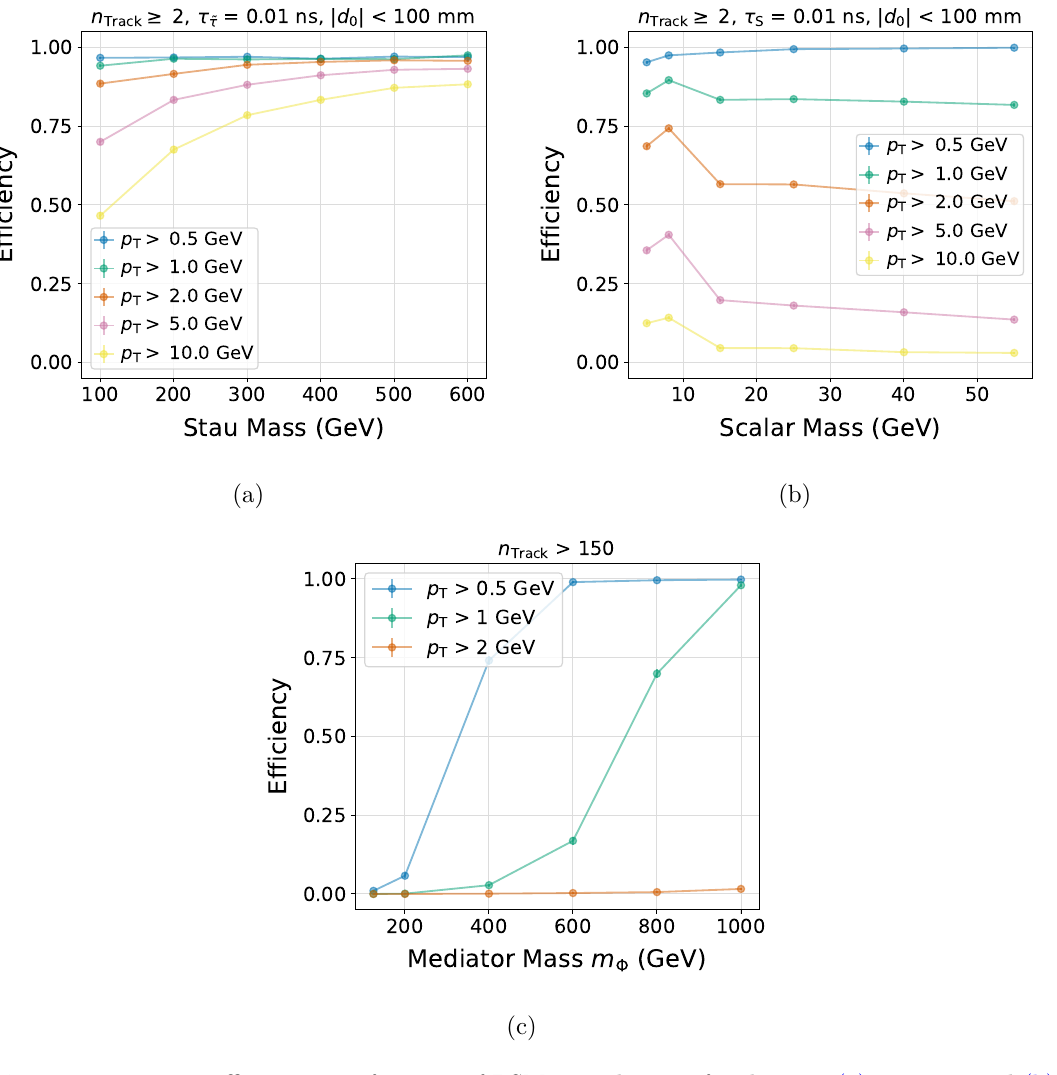
Figure 27. Trigger efficiency as a function of BSM particle mass for the stau (a), Higgs portal (b), and SUEPs (c) models for a range of minimum track p thresholds. The stau and Higgs portal T samples both correspond to a lifetime of τ = 0 . 01 ns in order to target displaced decay products. A linearly decreasing efficiency is assumed up to a | d endpoint of 100 mm, and both long-lived 0 | scenarios require n 2 . In the SUEP model all tracks are Track ≥